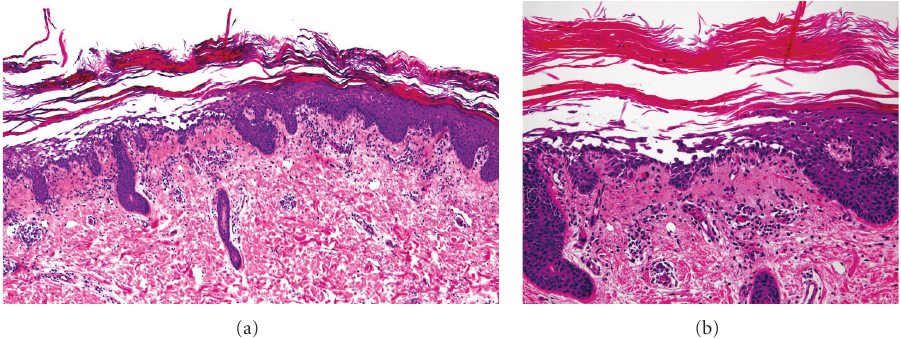
Figure 2: Skin biopsy, left abdomen. Alternating parakeratosis and orthokeratosis in the stratum corneum in vertical and horizontal sections. A focus of acantholysis in the epidermis with suprabasilar and subcorneal location. Within the superficial dermis, there is a sparse superficial perivascular and interstitial lymphocytic infiltrate. Hematoxylin-eosin stain (a) × 4 and (b) × 20